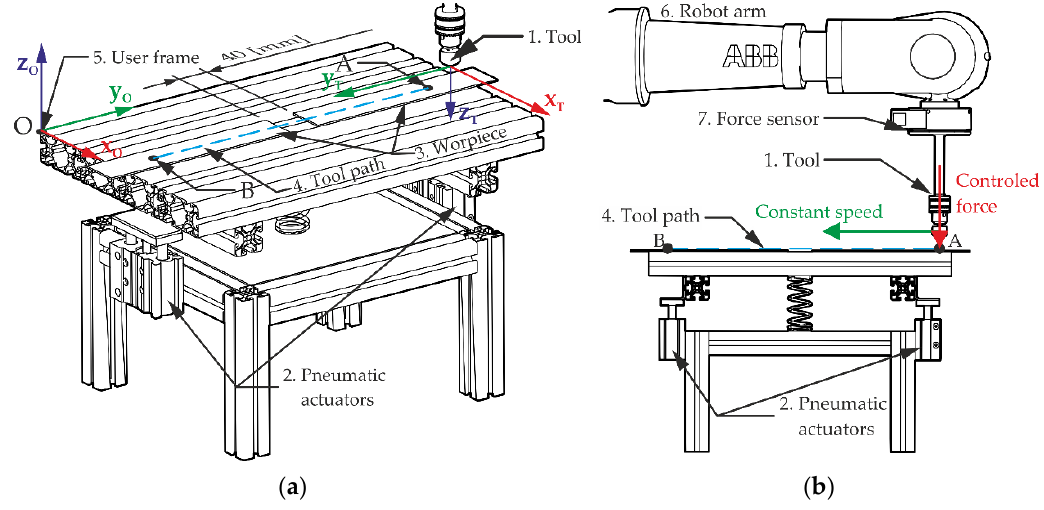
Figure 6. The scheme of the experiment: ( a ) Arrangement of coordinate systems on the test stand; ( b ) control strategy diagram.